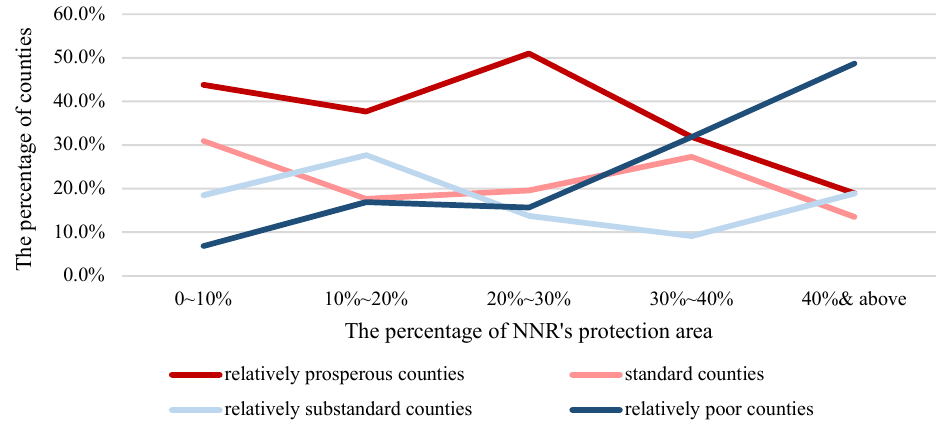
Figure 10. Percentage of protected area and number of counties and districts in 2019.